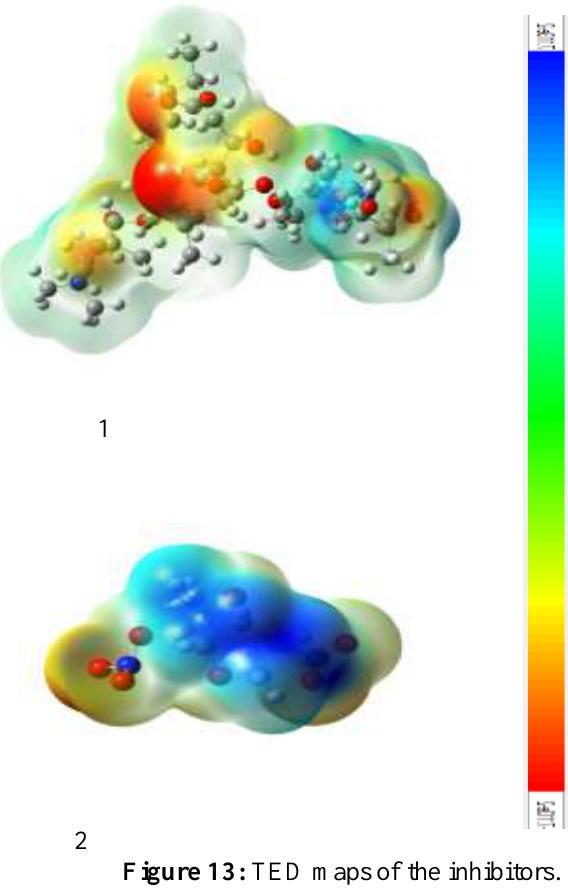
Figure 13: TED maps of the